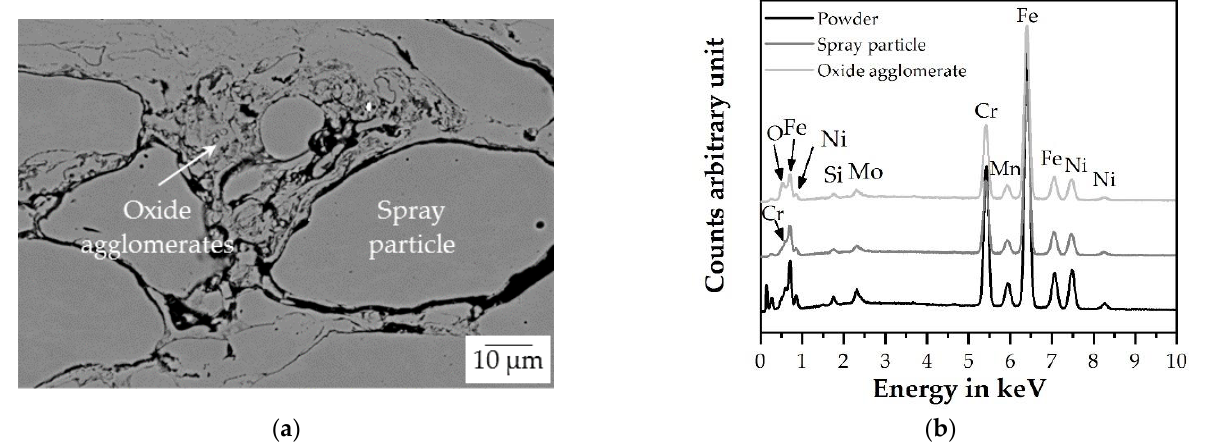
Figure 4. SEM investigation of an AISI 316L HVAF coating on mild steel in cross-section: ( a ) detailed BSD-SEM image and ( b ) EDX analysis of the powder and the coating. BSD-SEM image and ( b ) EDX analysis of the powder and the coating.